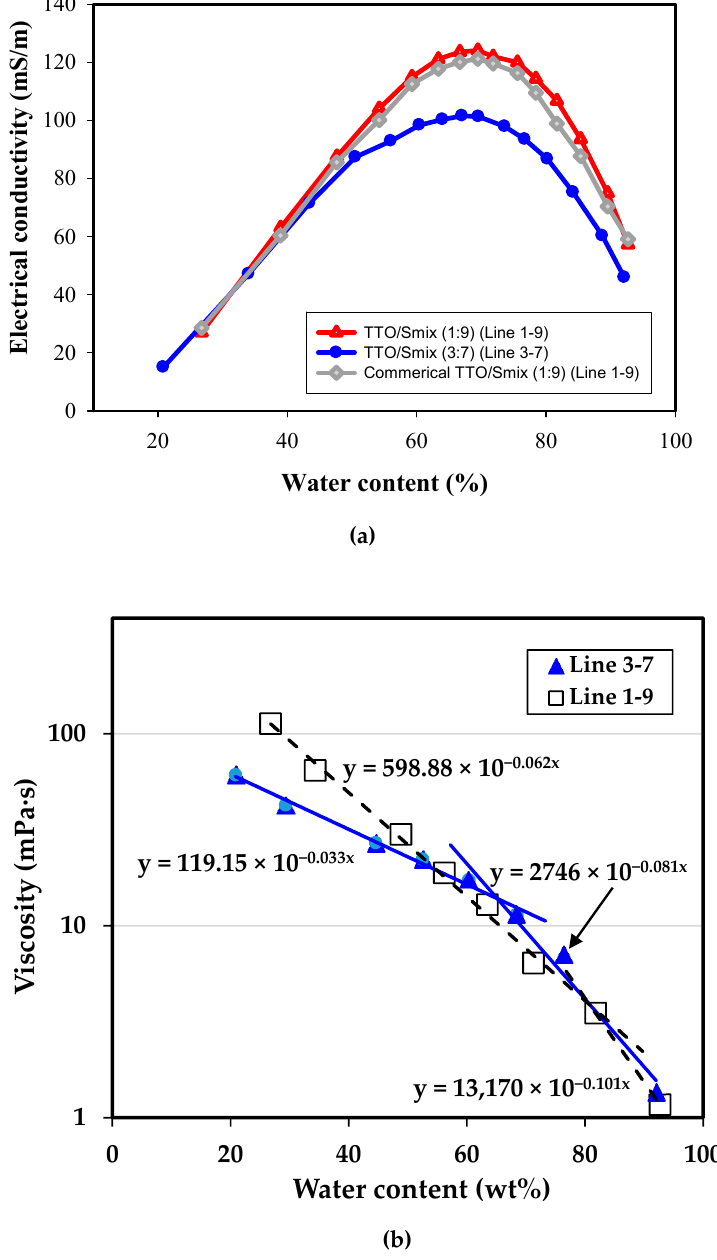
Figure 2. Properties of microemulsions prepared from dilution along Line 1–9 and Line 3–7: ( a ) Electrical conductivity; ( b ) Viscosity.